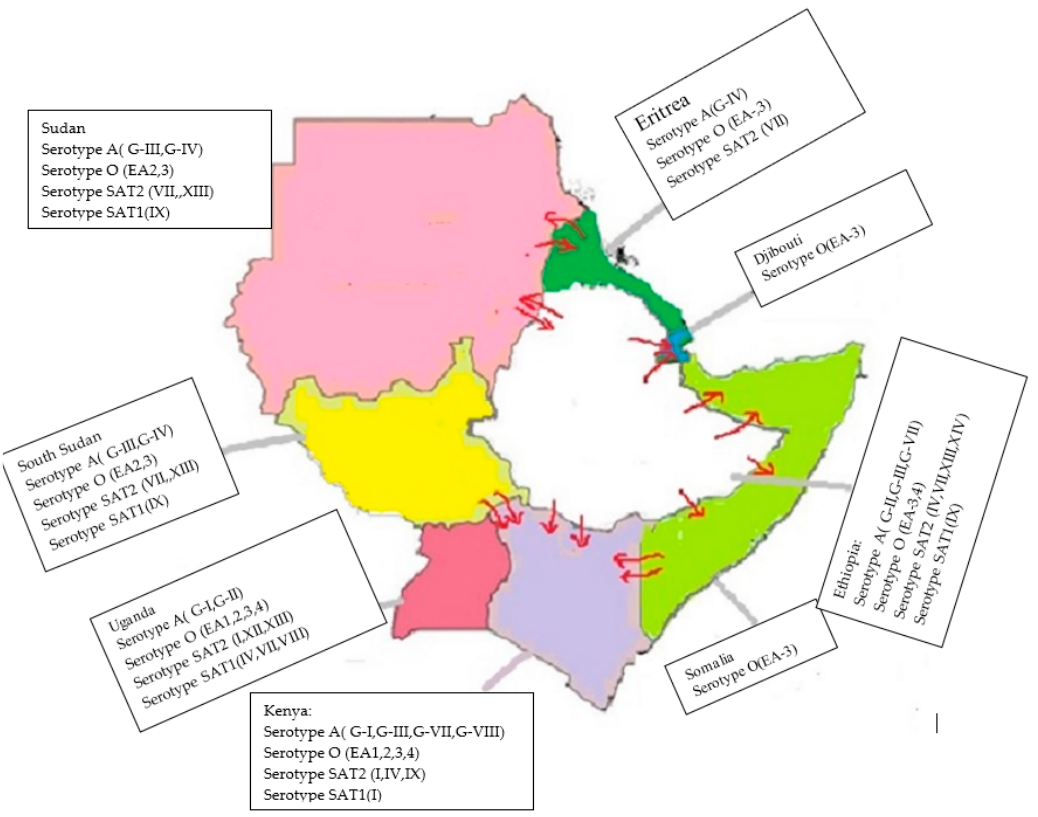
Figure 5. The circulating serotypes and topotypes of the foot-and-mouth disease (FMD) virus in the Horn of Africa. The possible cross-border livestock movement and dynamism of serotypes and topotypes are indicated by arrows.